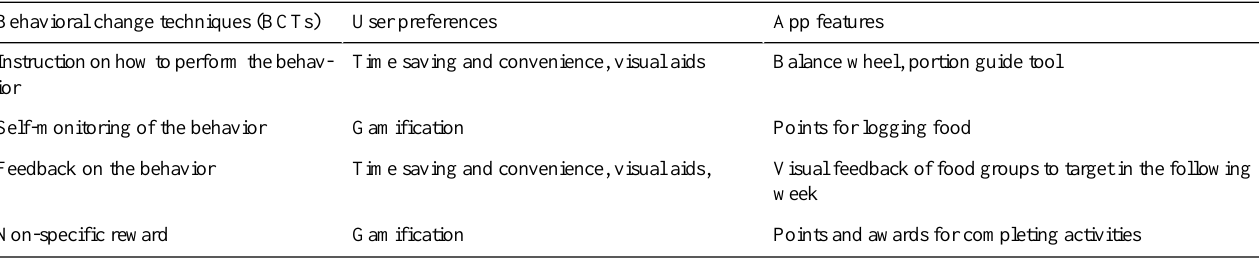
Table 5. Excerpt of examples of behavioral change technique (BCT) user-centered design (UCD) app